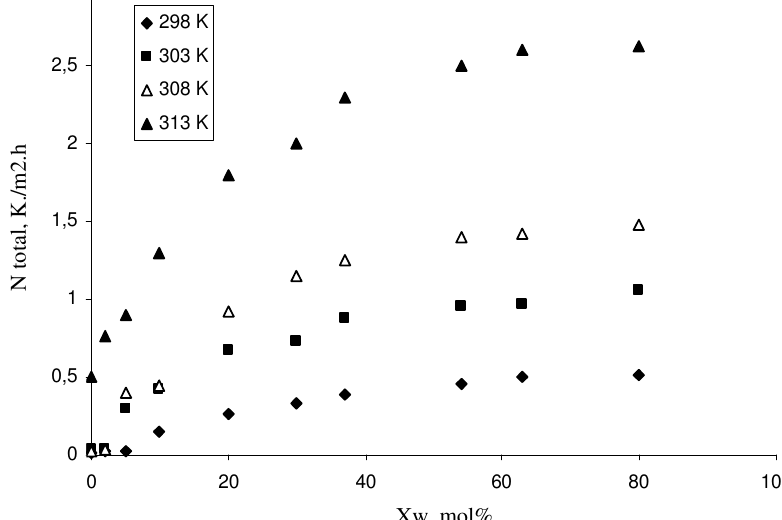
Figure 14. Evolution of total flow versus water feed with increasing